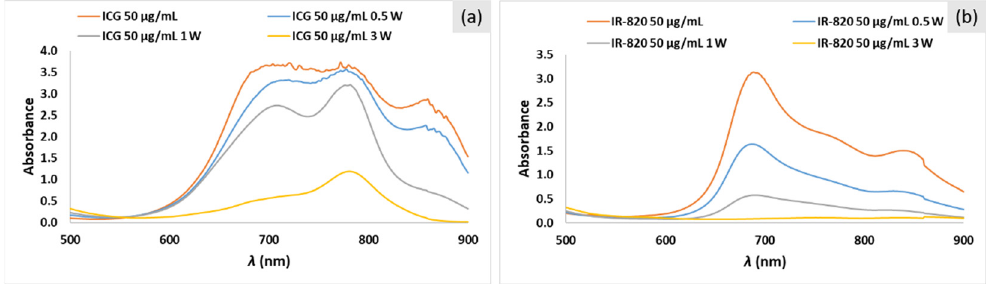
Figure 6. Absorption spectra of ( a ) ICG and ( b ) IR-820 solutions in PBS (50 μ g/mL) before and after laser irradiation with P = 0.5, 1, and 3 W/cm 2 for 5 min.